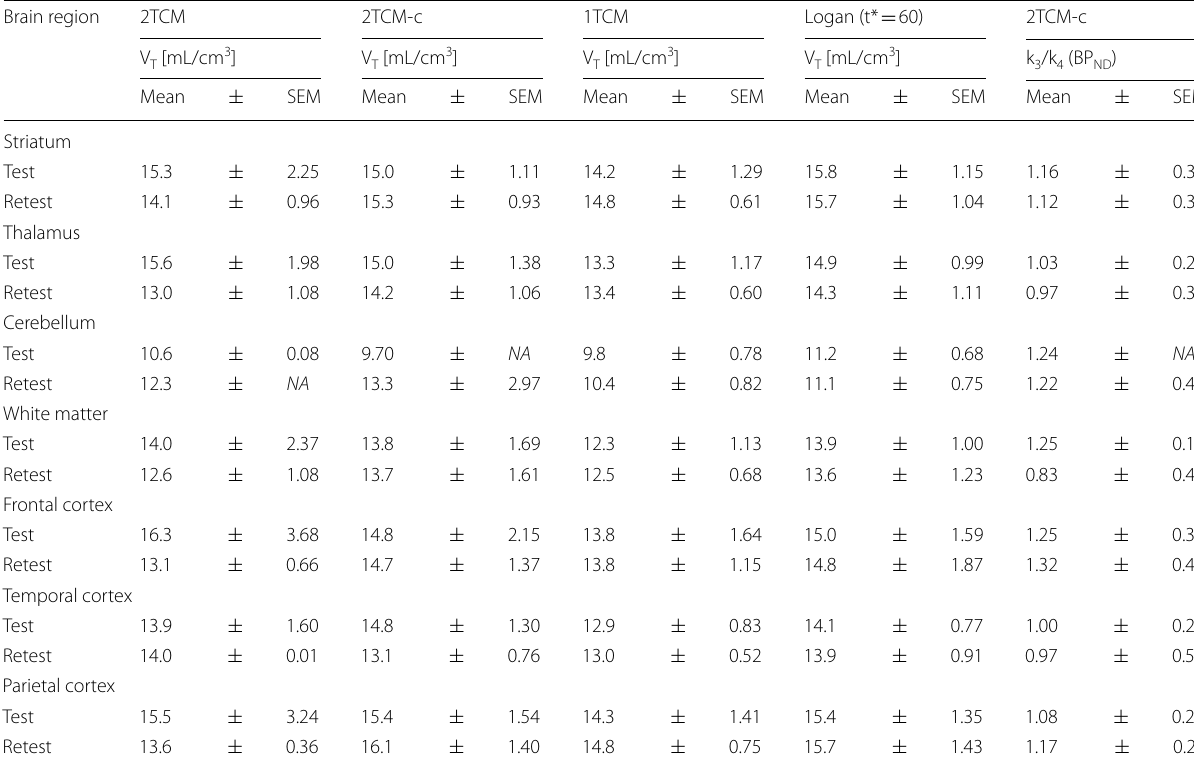
- and BP for test-, and retest scans T ND